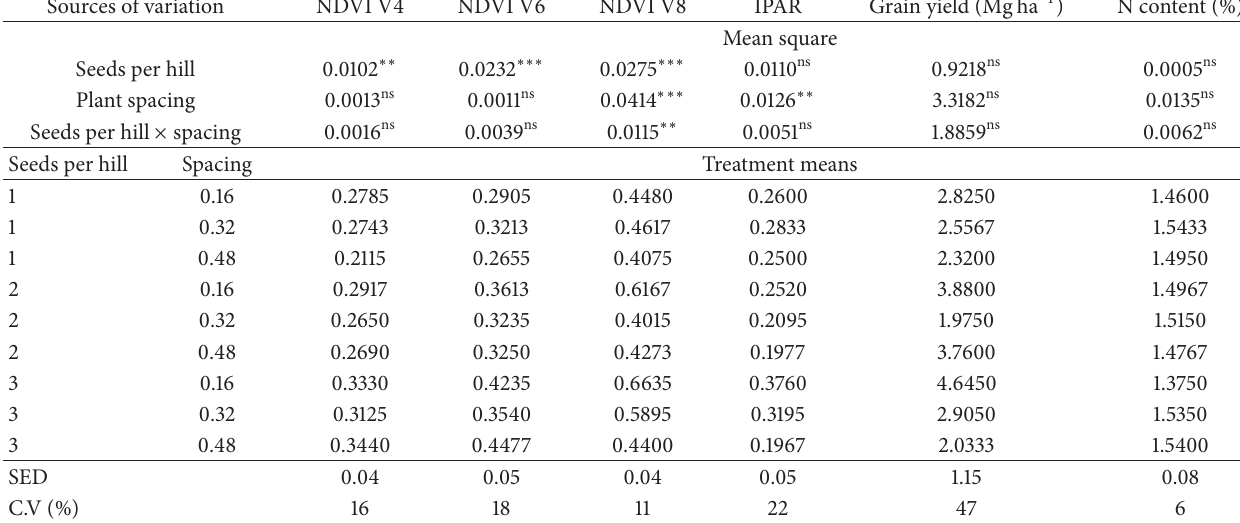
∗∗∗,∗∗ Significant at 0.01 and 0.05 levels of probability, respectively; ns: not significant; SED: standard error of the difference between two equally replicated means; C.V: coefficient of variation.